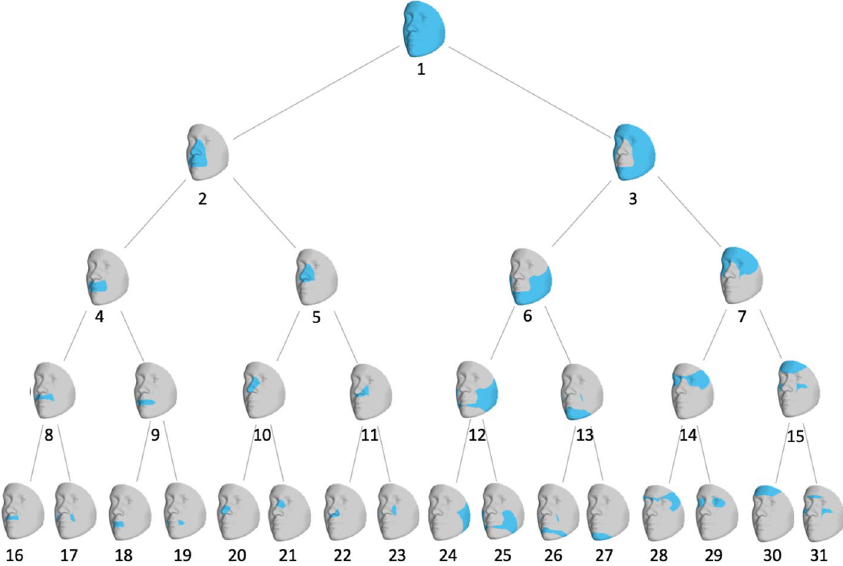
Figure 1. Hierarchical clustering of facial shape. Global-to-local facial segmentation obtained using hierarchical spectral clustering. Segments are colored in blue. The highest-level segment representing the full face was split into two sub-segments, and this bifurcation process was repeated until a five-level hierarchy comprising 31 segments was